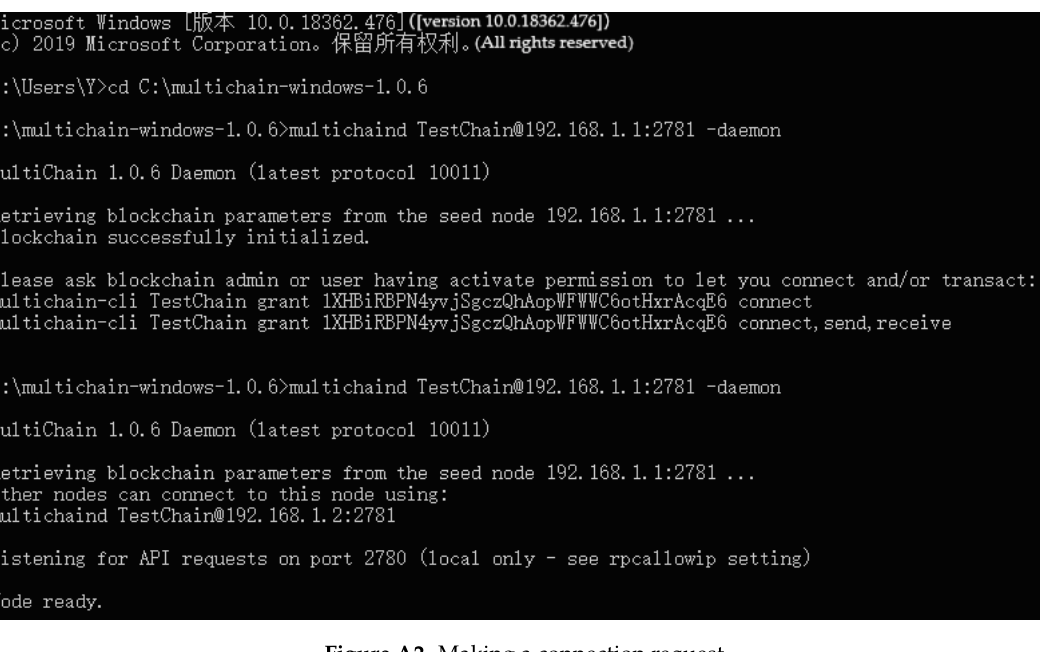
Figure A2. Making a connection request.